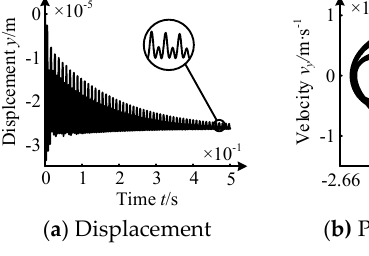
Figure 15. Operating law under upper and lower unit failure.